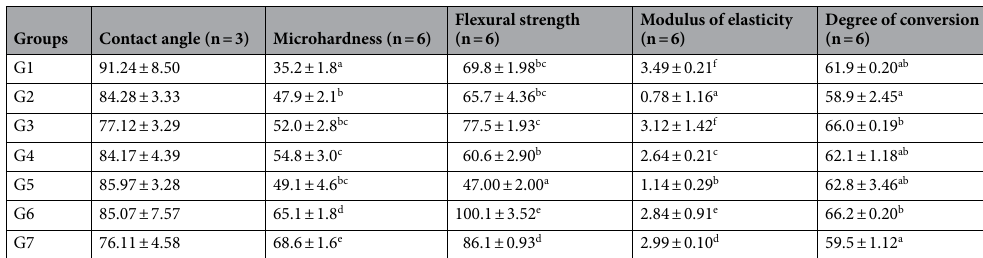
Table 2. Contact angle (°), microhardness (kg/mm 2 ), flexural strength (MPa), modulus of elasticity (GPa) and degree of conversion (%) values (mean ± SD) for the RBCs. Values in the same column with different superscript lower − case letters significantly differ from each other ( p <